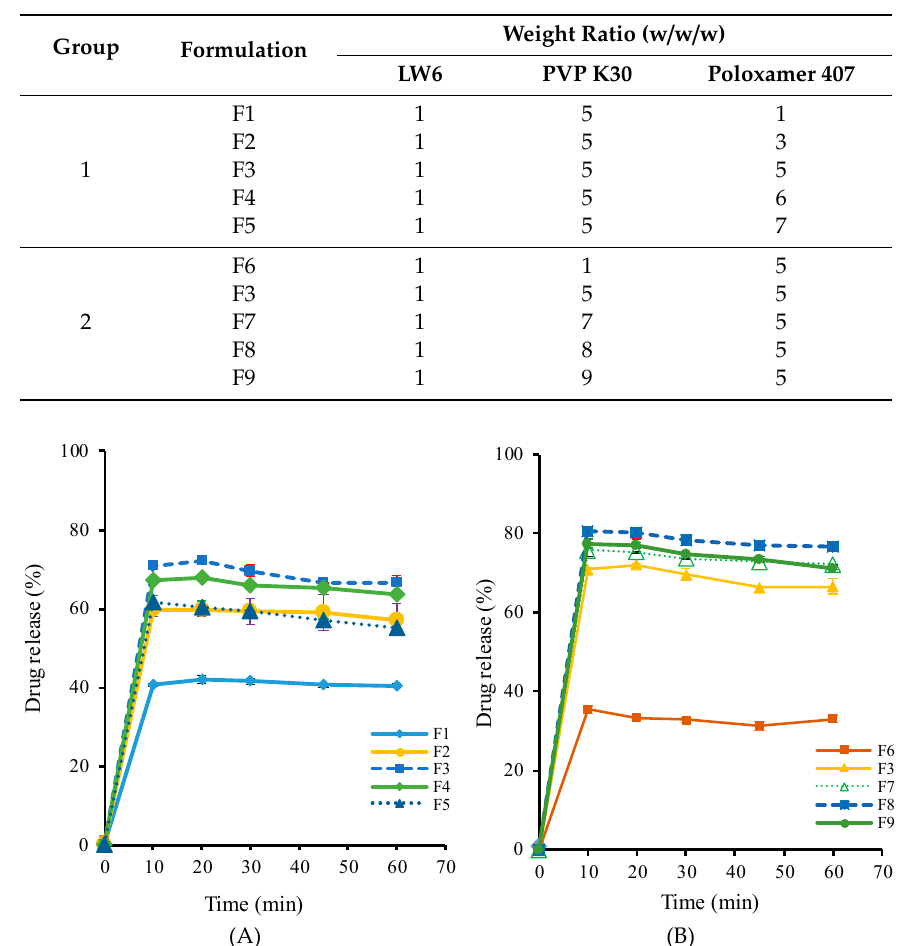
(B) Figure 6. Drug release profiles of the optimal SD formulation (F8-SD) in water. Data are expressed as the mean ± standard deviation (n = 3). ( A ) Comparison of SD, PM, and pure drug; ( B ) drug release profiles of F8-SD at different pHs. 3.3. Structural and Morphological Characterization of SD Formulation The structural and morphological characterization of the drug in SDs were performed using DSC, XRPD, FT-IR, and SEM as described below. 3.3.1. Differential Scanning Calorimetry (DSC) The DSC thermograms of pure LW6, PVP K30, poloxamer 407, F8-SD, and PM were obtained to examine the characteristics of thermal behaviors. As illustrated in Figure 7, LW6 exhibited a single and sharp endothermic peak at 279 °C, indicating its melting point. This high melting point also suggests its highly crystalline nature. Likewise, the thermogram of hygroscopic PVP K30 showed a wide endothermic peak at 150.57 °C due to the dehydration of polymer, while poloxamer 407 had a sharp peak at 55.55 °C; these are comparable to the values reported in the literature [24,33]. The